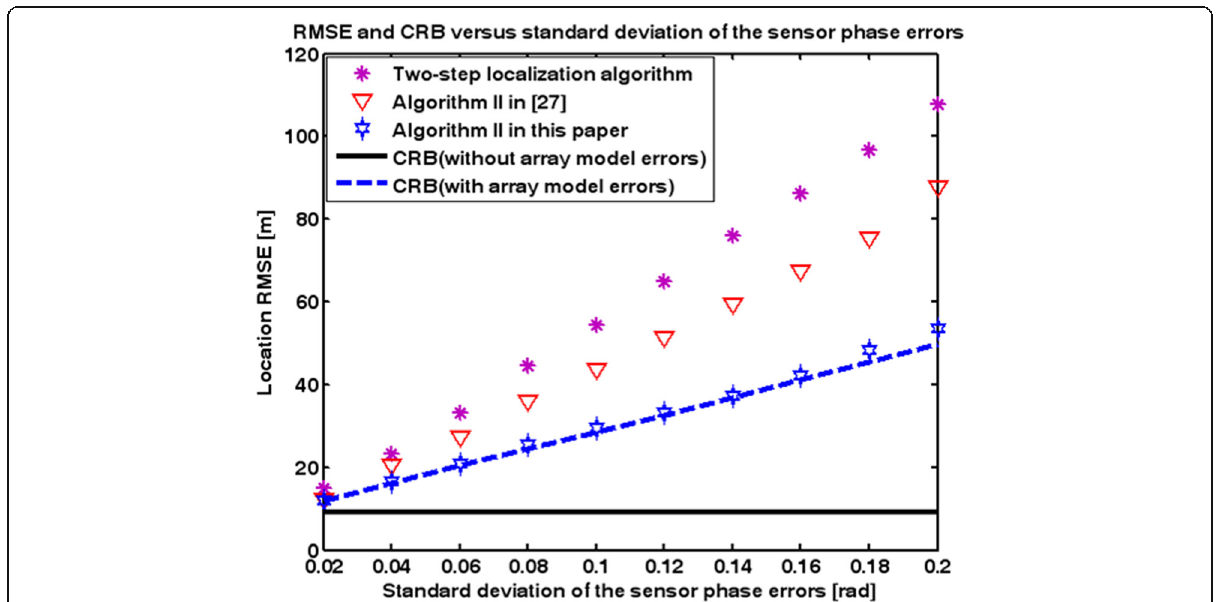
Fig. 9 RMSEs of localization methods and the corresponding CRBs as a function of standard deviation of sensor phase errors for case of known signal